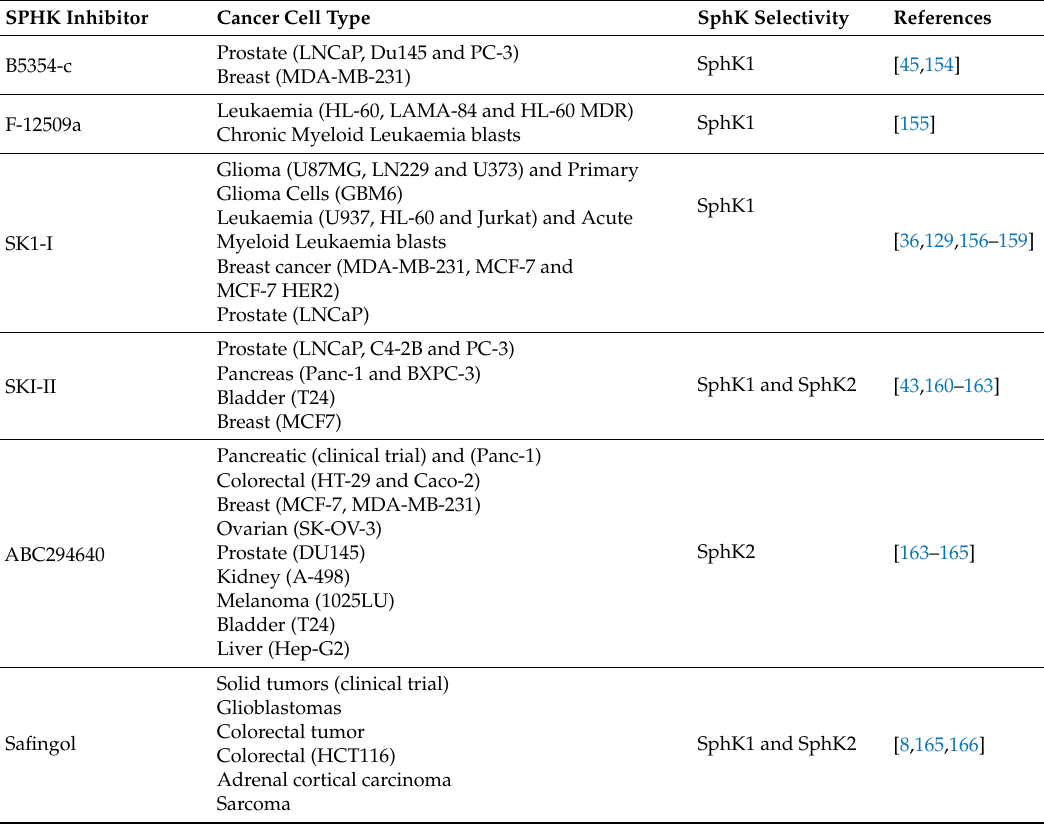
Table 3. SphK inhibitors tested in human cancer cells and primary human cancer